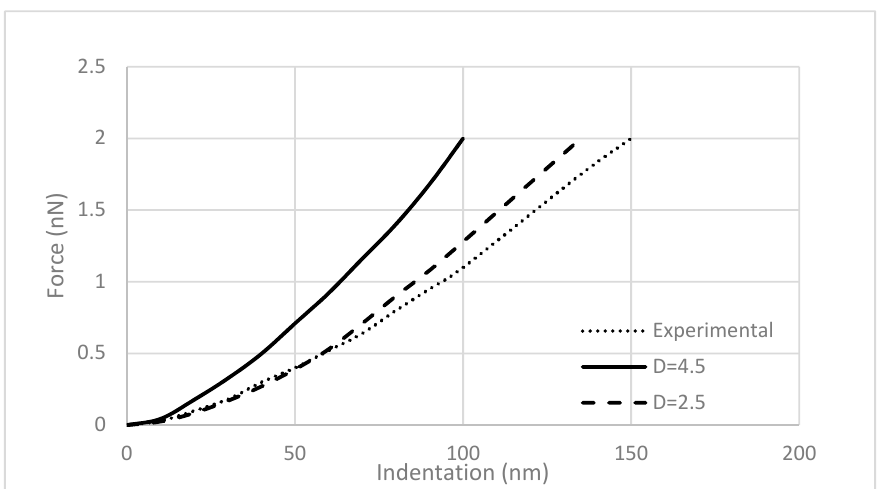
Figure 6. Comparison of the results from the atomic force microscopy (AFM) test for a single chondrocyte and present model. The solid and dashed lines show the results of the simulation with 4.5 and 2.5 μ m tip diameter, respectively.